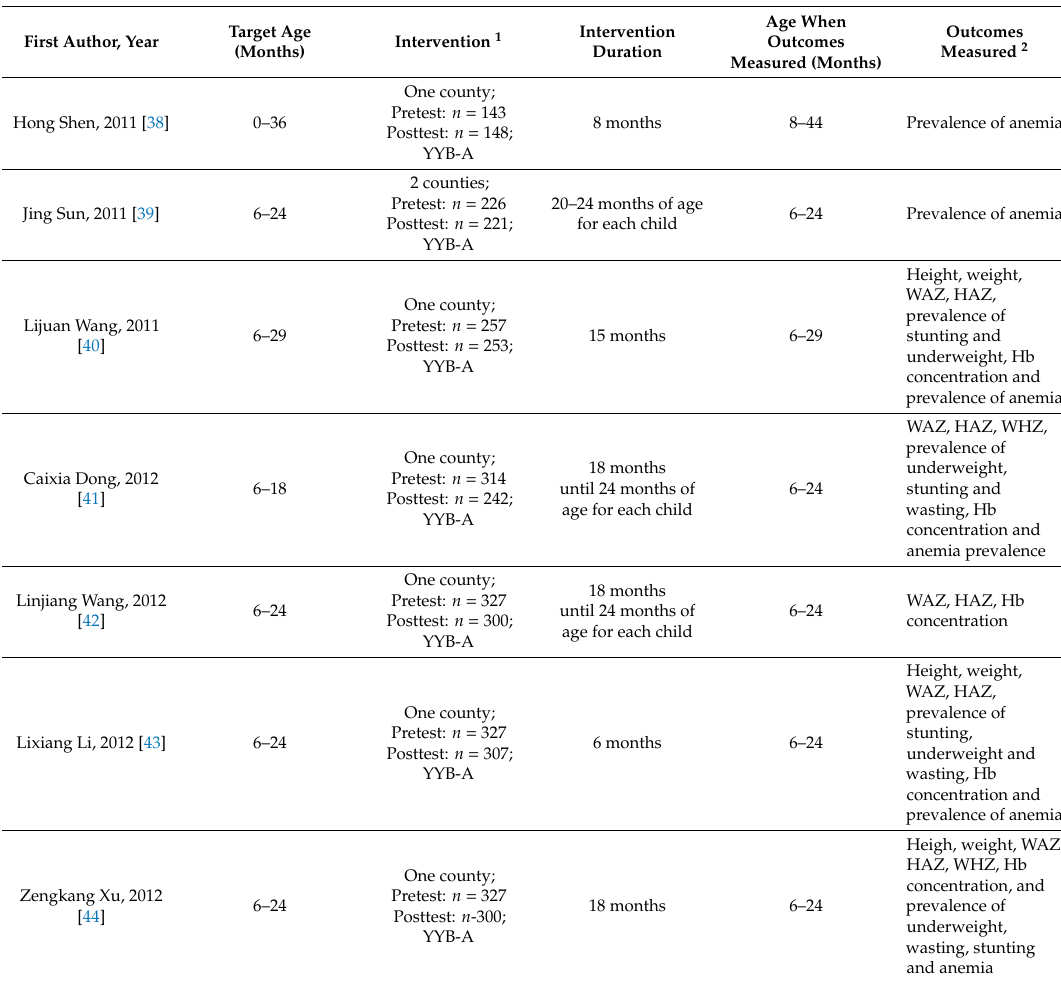
Table 2. Characteristics of pre-post